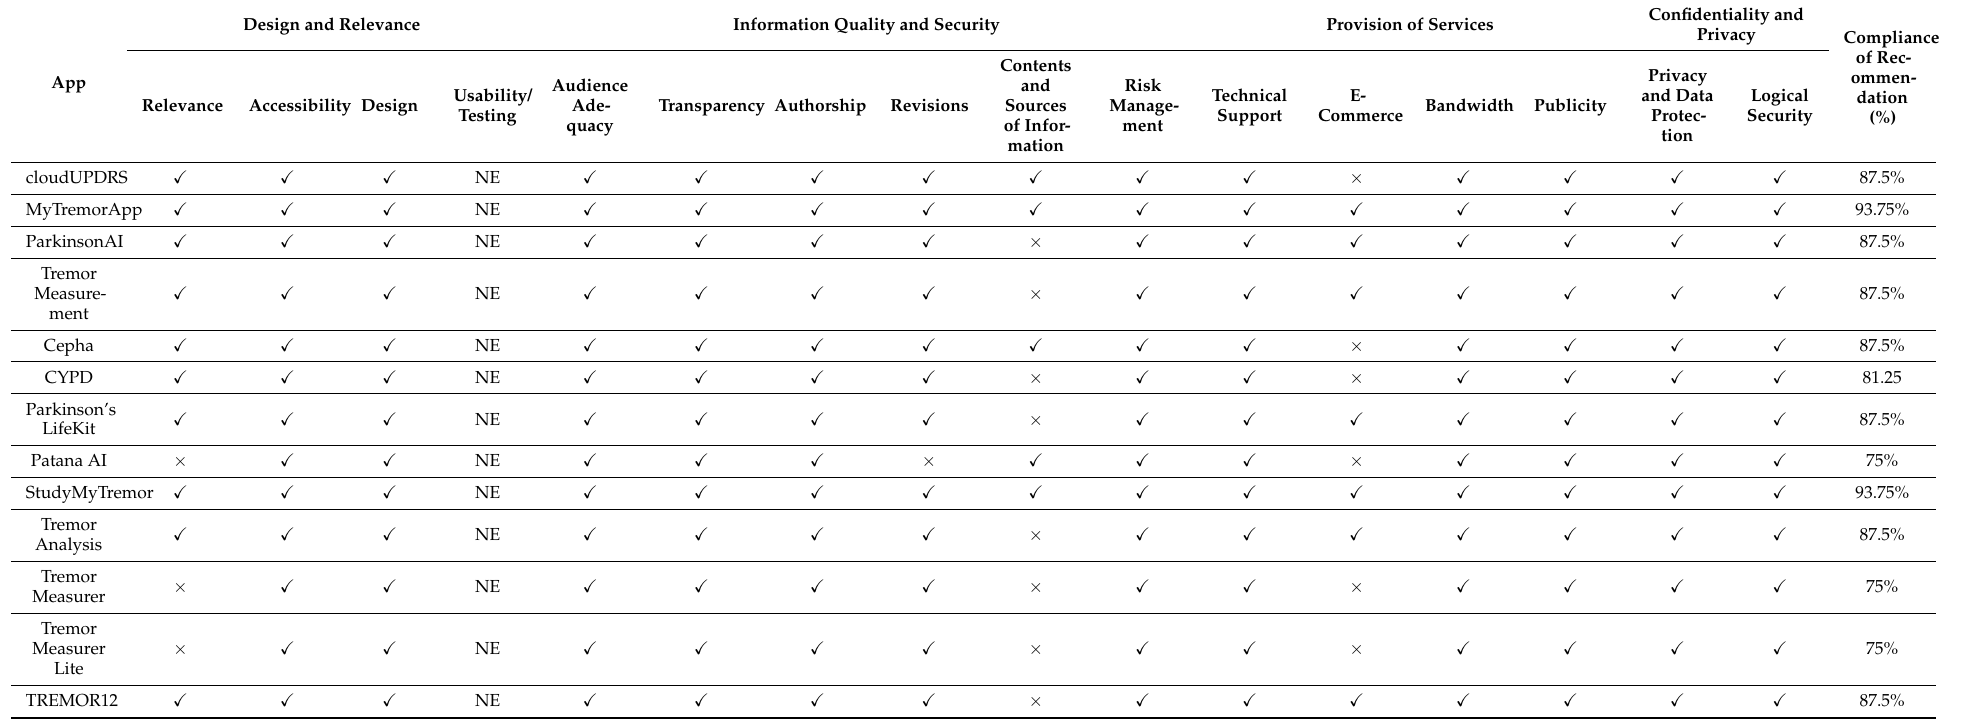
Table 5. Main quality characteristics of the apps